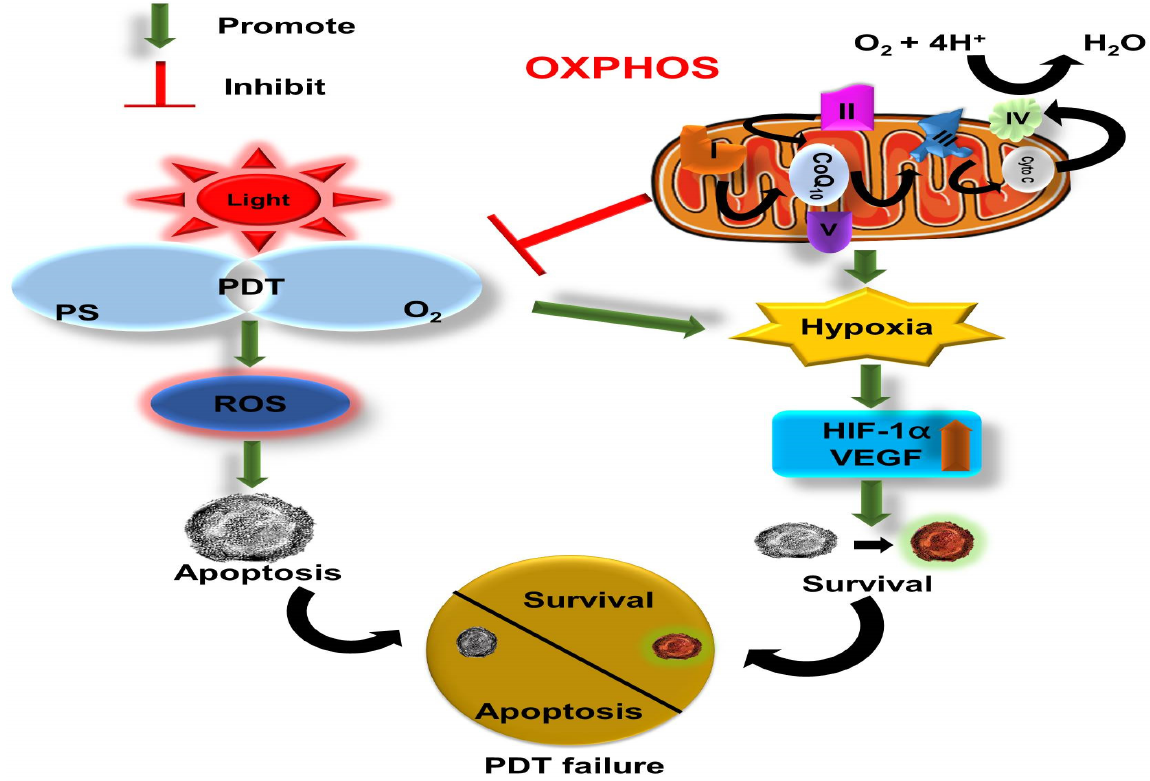
Figure 4. Hypoxia-mediated resistance in PDT treatment.